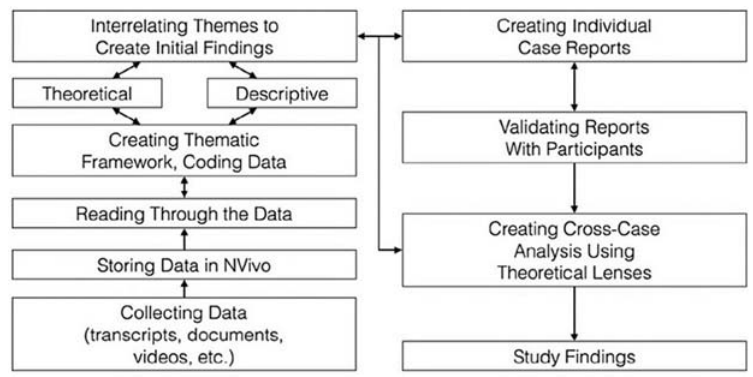
Figure 1. Data Collection and Analysis Steps.